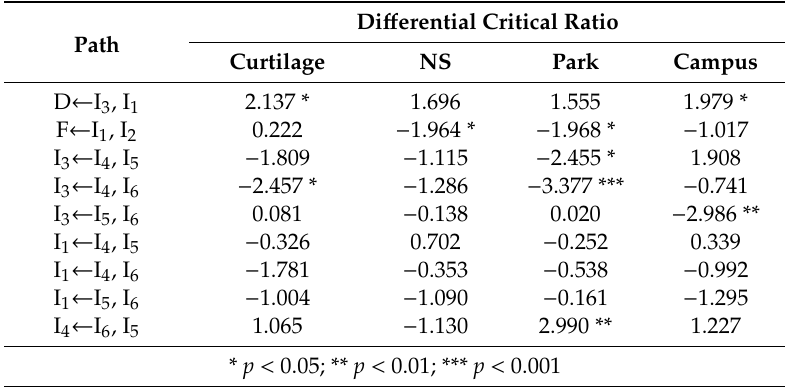
Table 2. Di ff erential critical ratio of paths in the groups. Di ff erential Critical Path